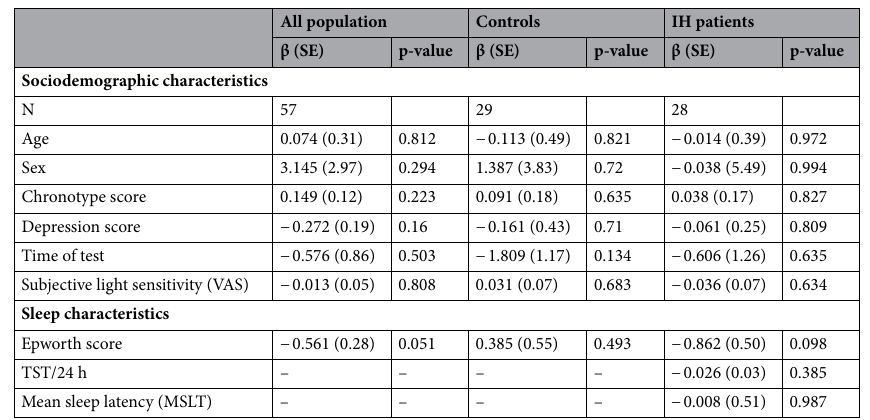
Table 2. Linear regressions between relative PIPR and sociodemographic/sleep characteristics for all volunteers, and for each diagnostic group (29 Controls and 28 IH with Long Sleep Time). Linear regressions were realized in the whole population (57 volunteers) and in each group (control group and IH group). No covariate was included in the analysis. IH idiopathic hypersomnia patients with long sleep time, Controls